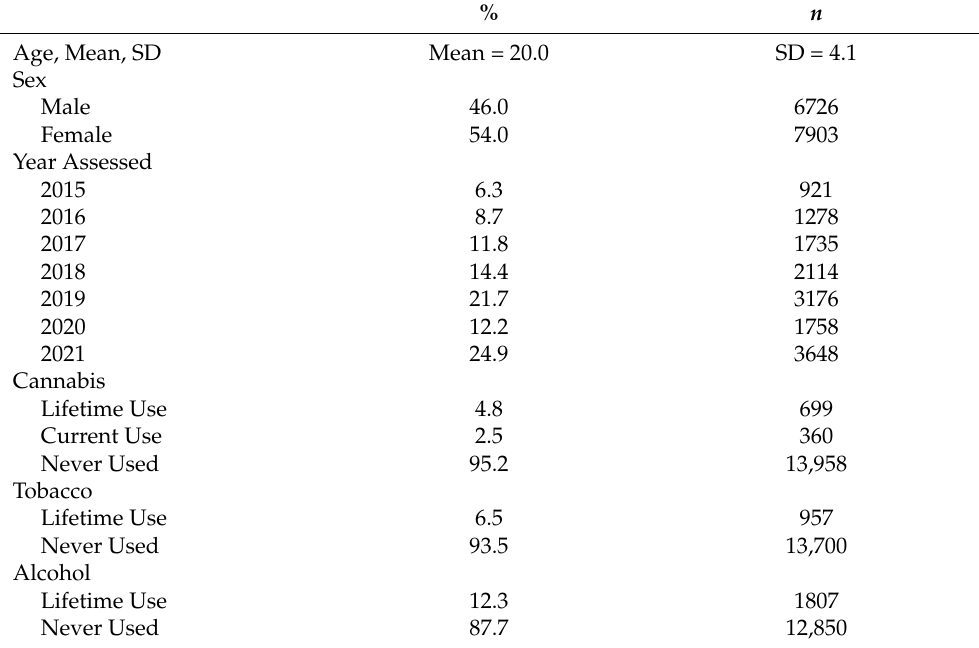
Table 1. Sample Characteristics ( n =